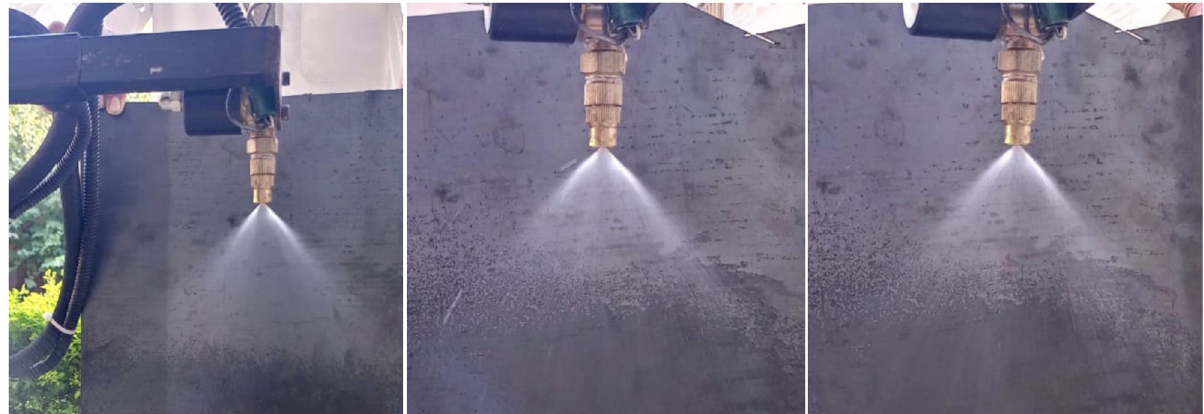
Fig 11. Constant spray angle achieved under different number of active solenoid valves at constant pressure.